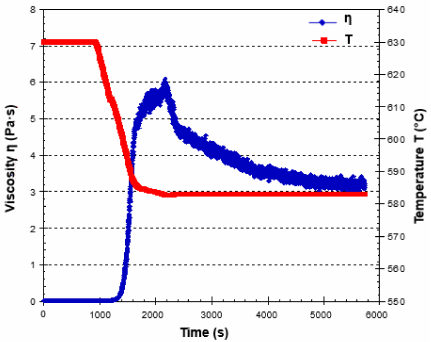
Figure 5. Plot of viscosity versus time at constant shear rate (100 s − 1 ) during cooling from liquid state (630 ◦ C) to semi-solid condition (solid fraction of 0.35 at 583 ◦ C) for an Al-Si alloy measured by means of a Searle rheometer [12].